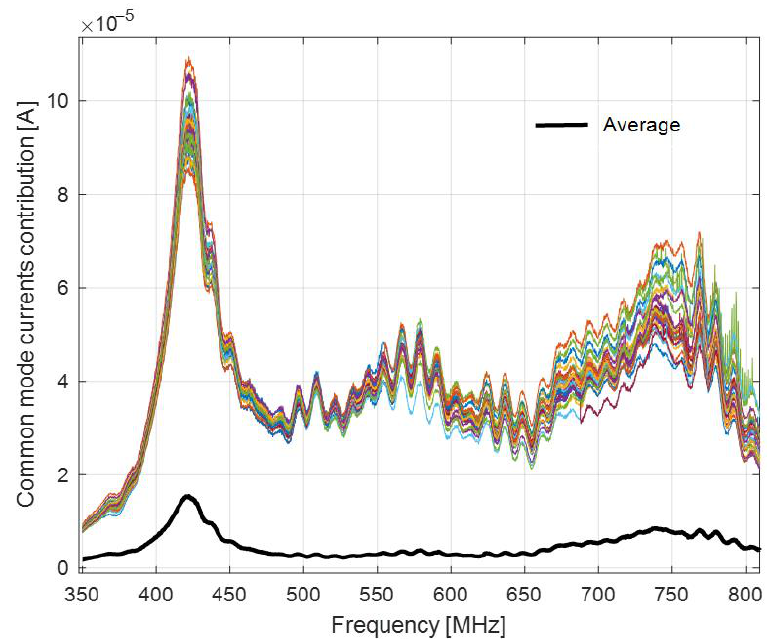
Figure 30. Contribution of the common mode current to the output current versus the distance- averaged figure.